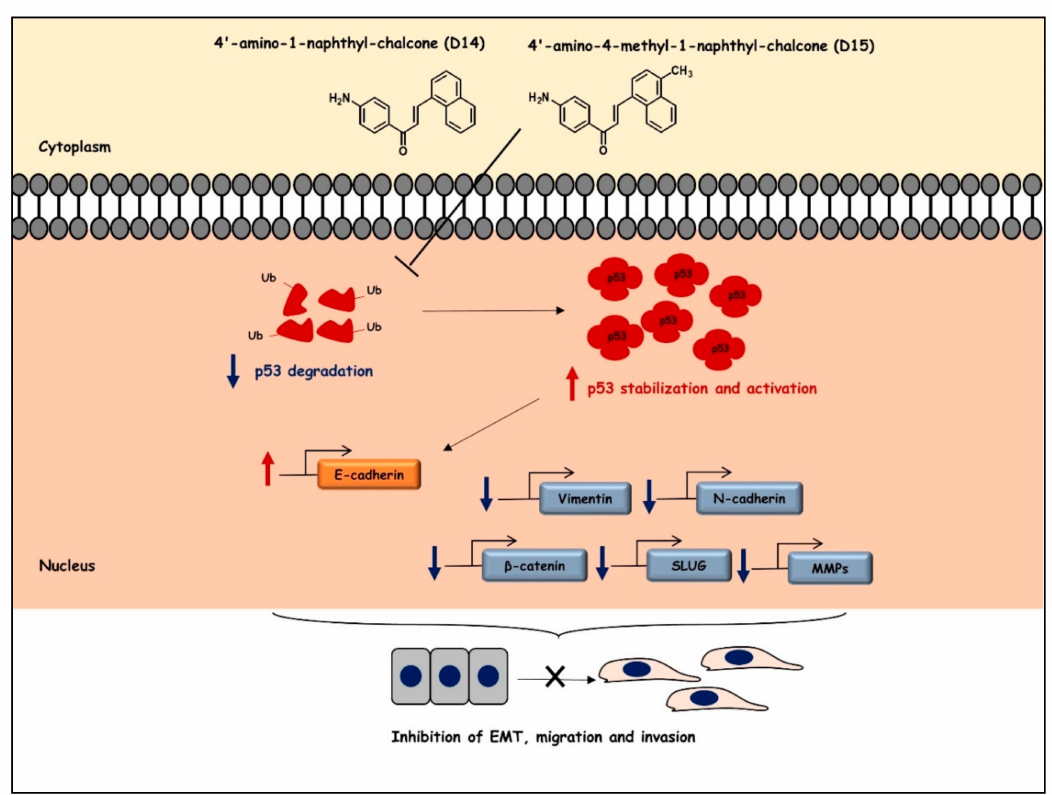
Figure 5. A proposed model for the action of chalcones D14 and D15 in osteosarcoma cells. D14 and D15 upregulated p53 protein levels, thus regulating metalloproteinases (MMPs) and EMT-related genes and promoting the inhibition of cell migration and